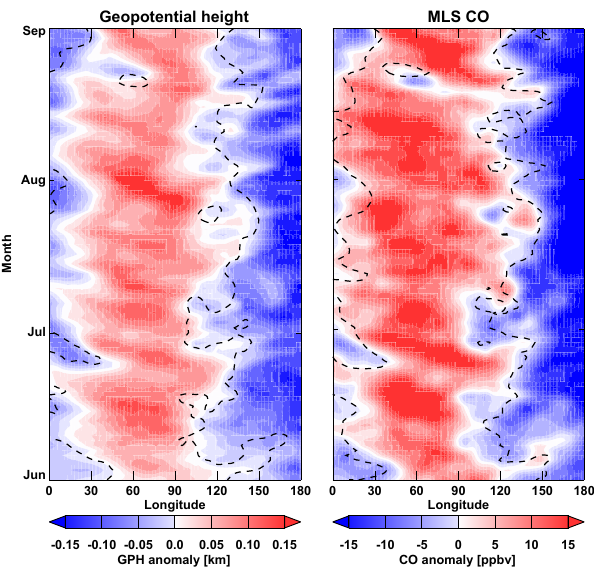
opposite field. The Pearson’s correlation of the two fields for the 3-month period is